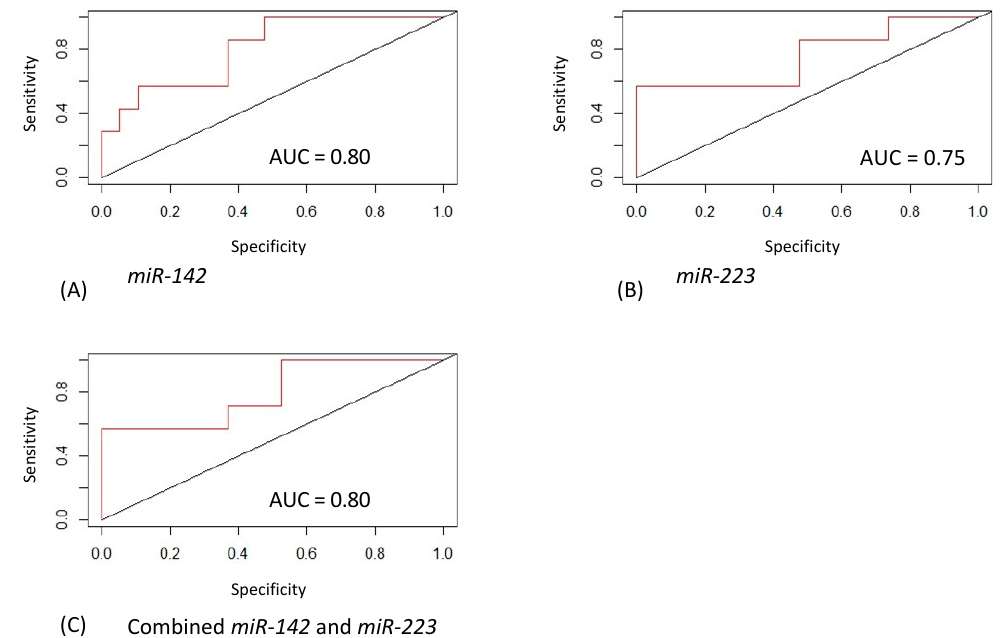
Figure 5. Classification performance by receiver operating characteristic (ROC) to discriminate responsive vs. nonresponsive epilepsy patients. A logistic regression model was applied using expression levels of ( A ) miR-142 (area under curve (AUC): 0.80), ( B ) miR-223 (AUC: 0.75), and ( C ) combined miR-142 and miR-223 (AUC: 0.80).